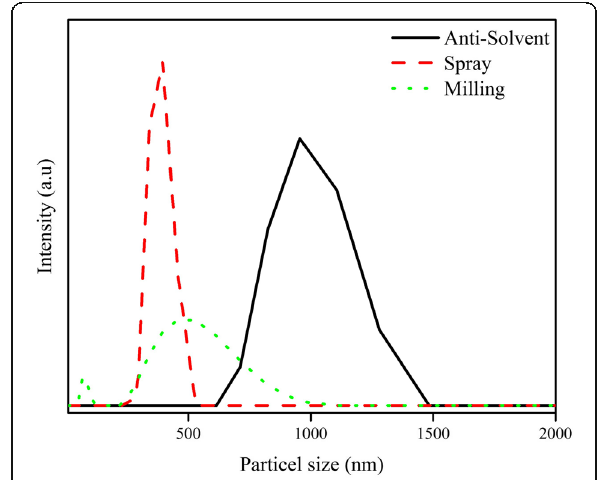
Fig. 4 Particle size distribution of perovskite particles prepared using three different